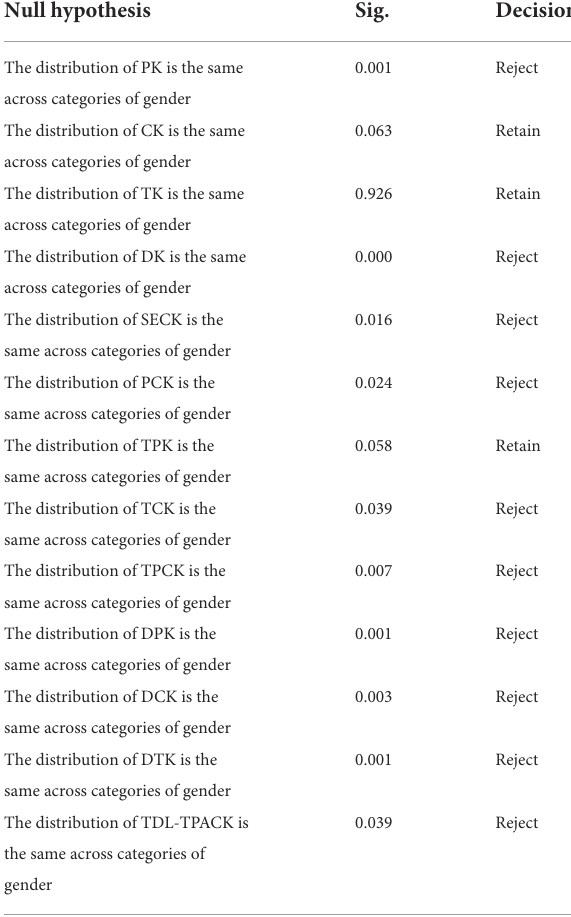
TABLE 6 Mann–Whitney U test for TDL-TPACK in